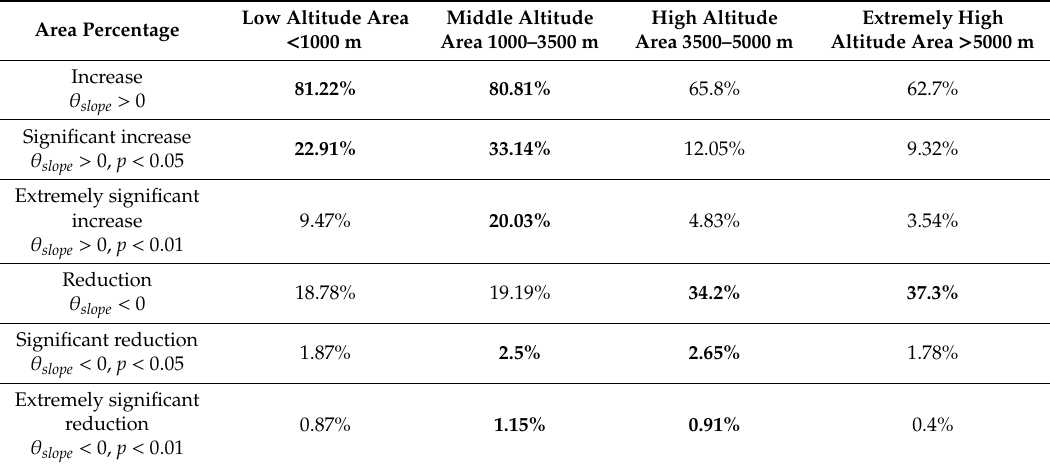
Table 1. Statistics of NDVI changes in the TP from 2001 to